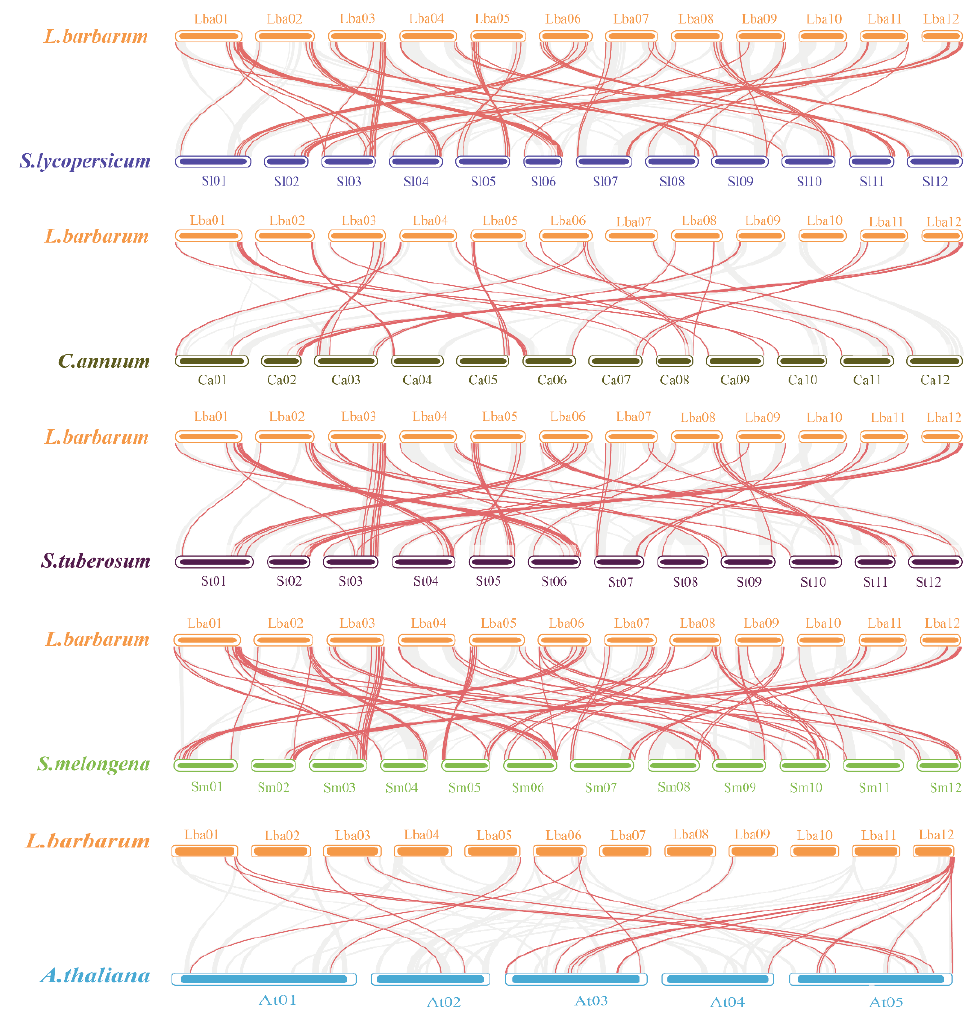
Figure 5. Synteny analyses of R2R3-MYB genes between wolfberry and the five representative species. The gray lines in the background indicate the collinear block with wolfberry and other five plant species genomes, while red lines highlight syntenic R2R3-MYB gene pairs, respectively.